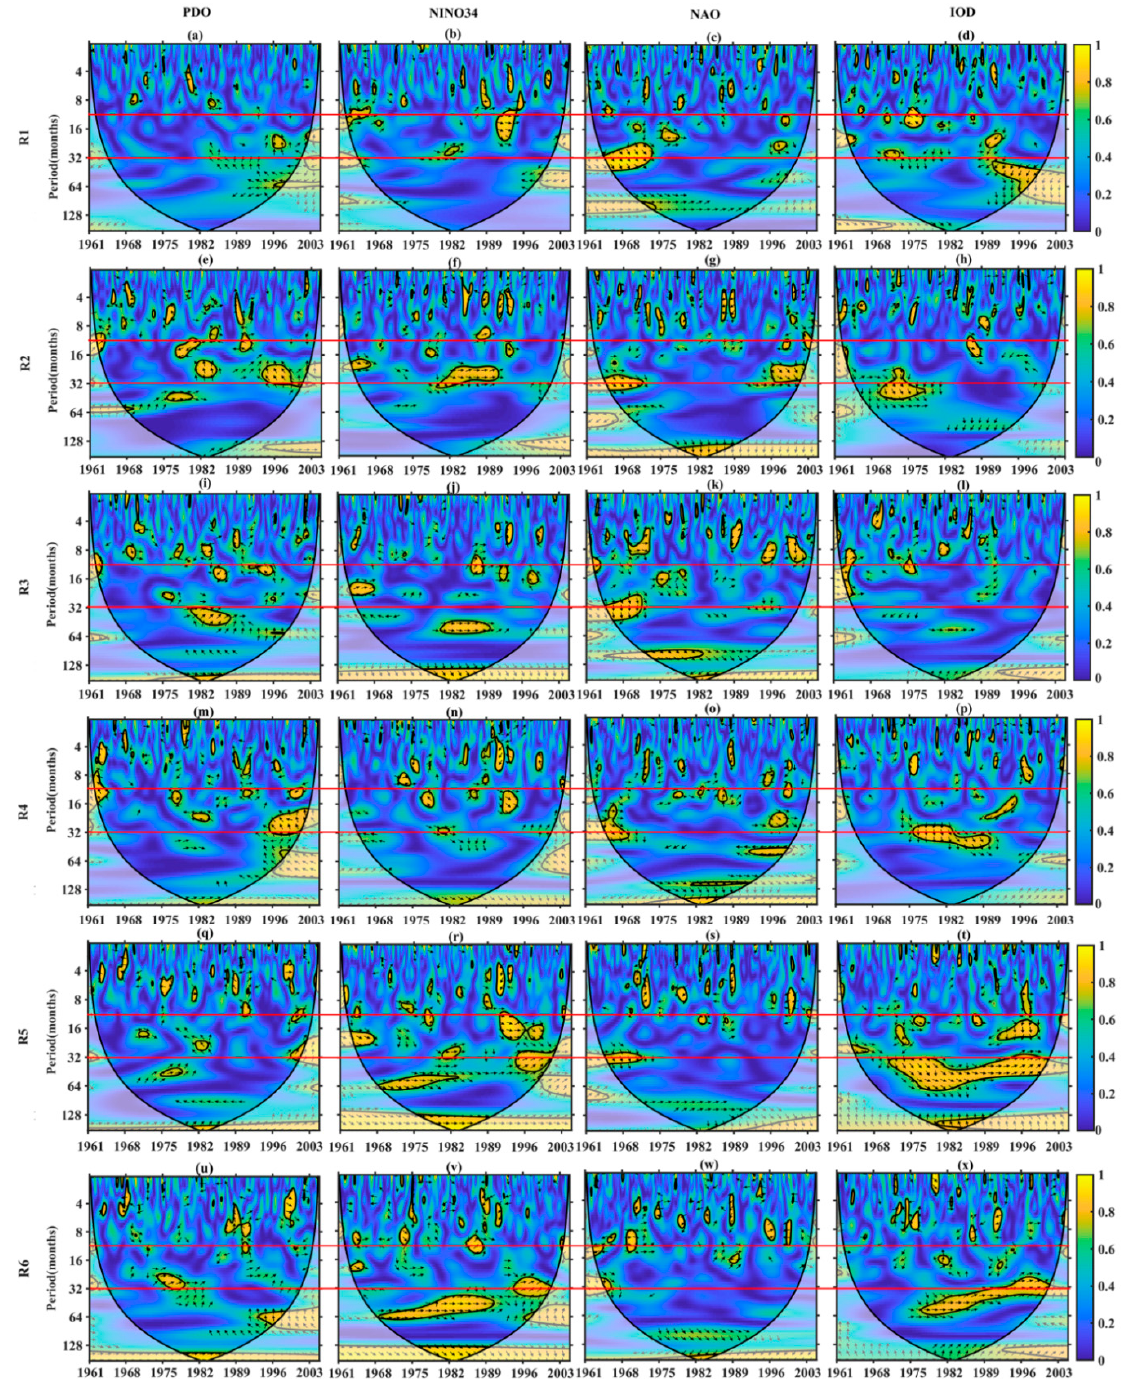
Figure 8. Squared wavelet coherence (WCO) between the large-scale climate indices and sub-regional SPI series. The colors from blue to yellow indicate the increasing coherence. The 5% significance level against red noise is shown as a black contour. The COI where the edge effects are not ignored is shown as a light-shaded area. The relative phase relationship for the two signals is shown as arrows (with in-phase pointing right, out of phase pointing left, climate indices leading SPI by 90° pointing straight up, and SPI leading climate indices by 90° pointing straight down).